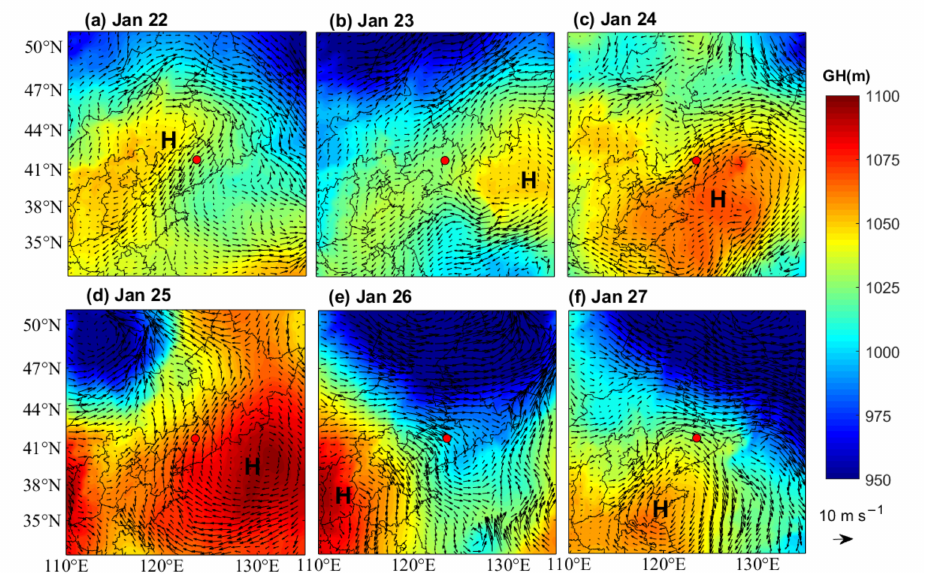
Figure 3. The 900 hPa geopotential height (GH) fields (colored areas) and wind vector fields (arrows) at 08:00 LT on ( a ) 22 January, ( b ) 23 January, ( c ) 24 January, ( d ) 25 January, ( e ) 26 January, and ( f ) 27 January 2021, over the North China Plain and Northeast China. The approximate locations of high pressure systems are denoted by the letter “H”. The red circle indicates